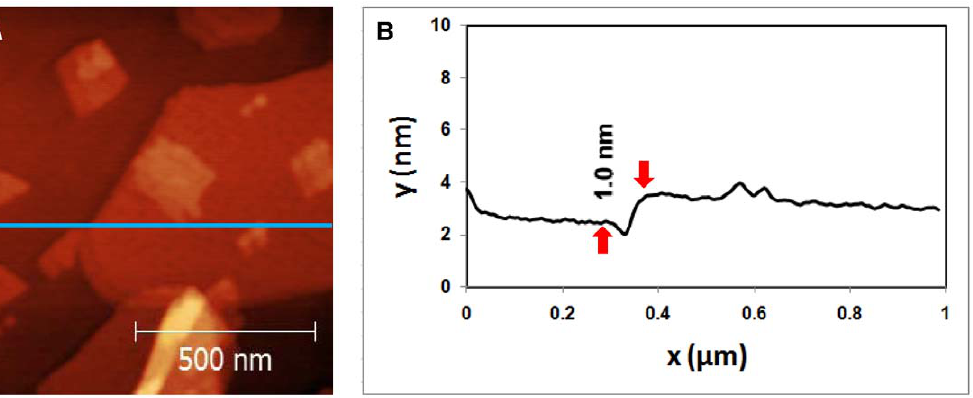
Figure 3. Topography of Mica/GaAl 12 /Nanosheets sample. (A) AFM image of delaminated SNT adsorbed mica surface. (B) Cross sectional image along the blue line shown in (A).